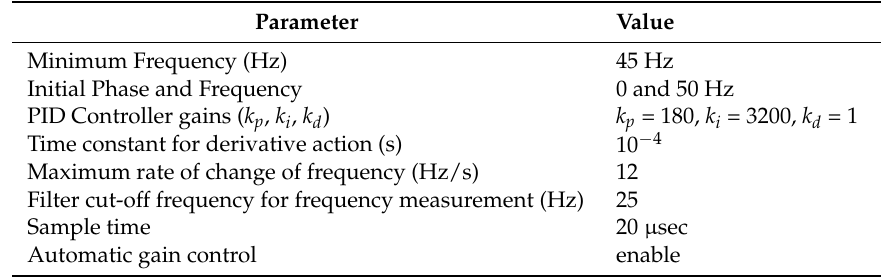
Figure 4. Single-phase phase-locked loop (PLL) used for both ideal and distorted grid voltage cases. Table 3. PLL parameters.